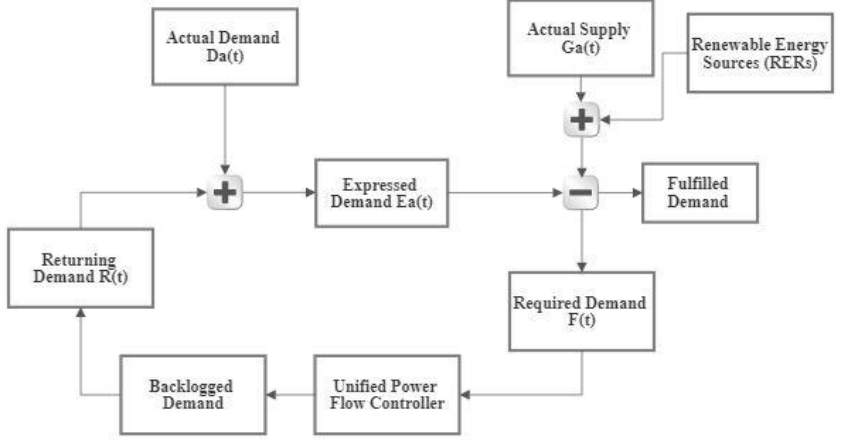
Figure 9. Block diagram of closed-loop control system for UPFC modeling .